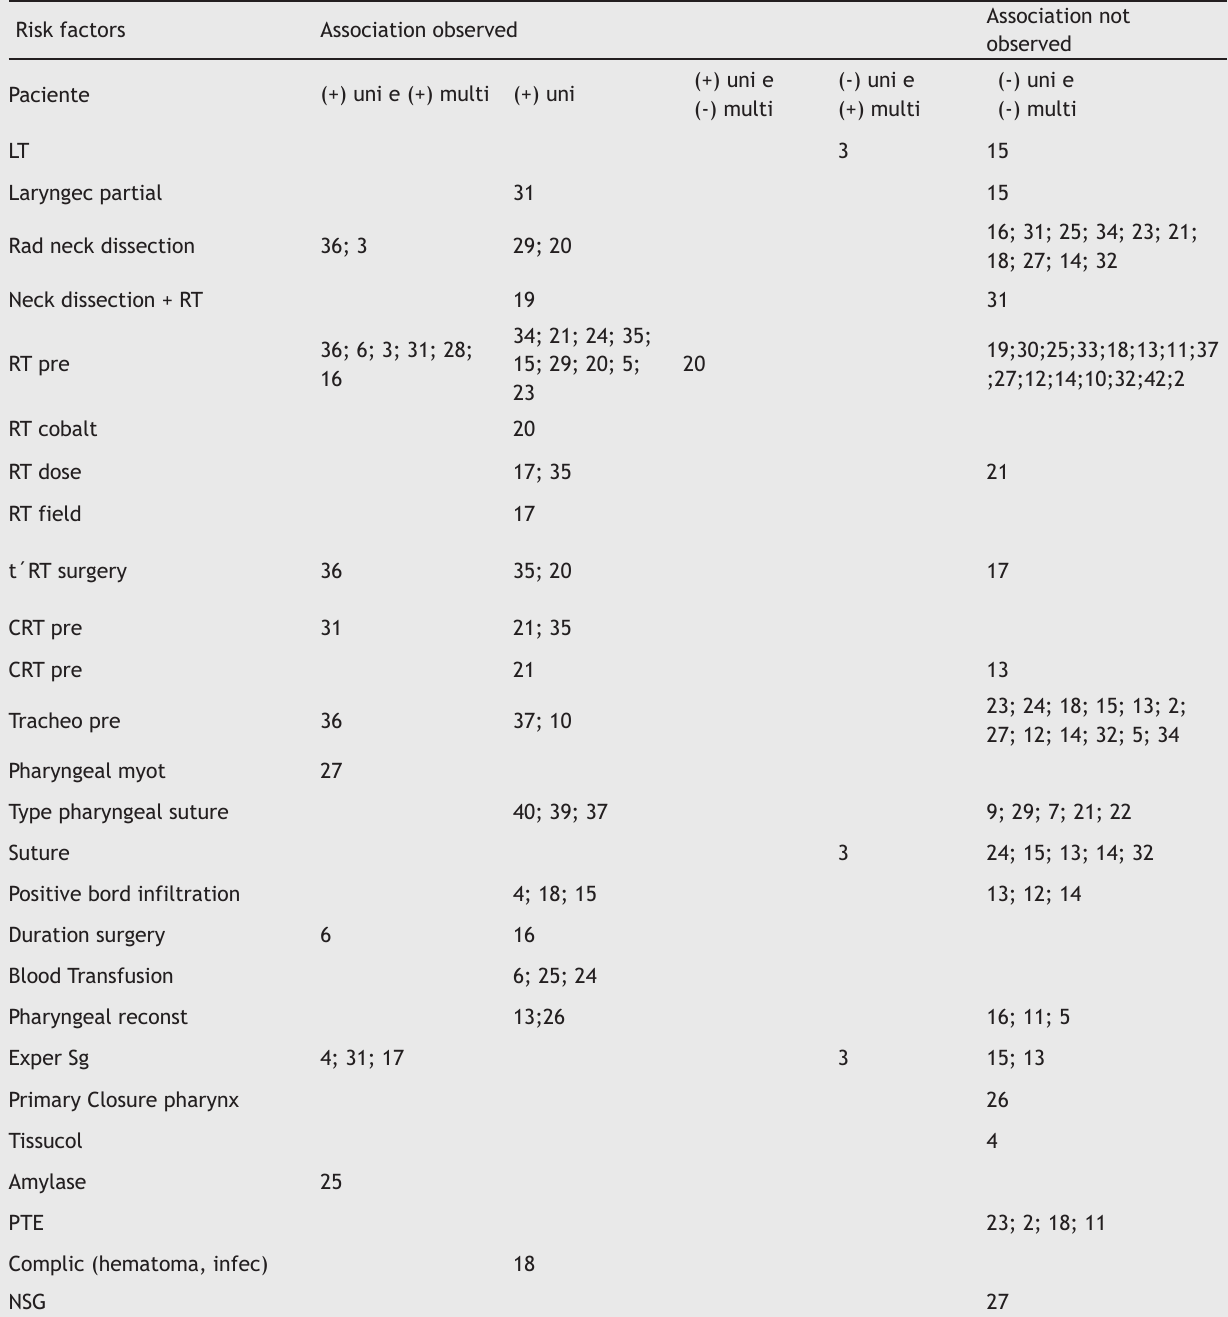
Table 2 Observed association between the presence of risk factors and development of pharyngocutaneous fistula with the univariate and multivariate analysis: (+) uni , observed association with univariate analysis and the multivariate analysis was not performed; (+) uni and (+) multi , an association was observed between the presence of risk factors and development of the pharyngocutaneous fistula in the univariate and multivariate analyzes; (+) uni and (-) multi , observed association in univariate analysis and it was not observed in multivariate analysis; (-) uni and (+) multi , an association was observed in the multivariate analysis and was not observed in the univariate analysis; (-) uni and (-) multi , no association was observed in the univariate and multivariate analysis.